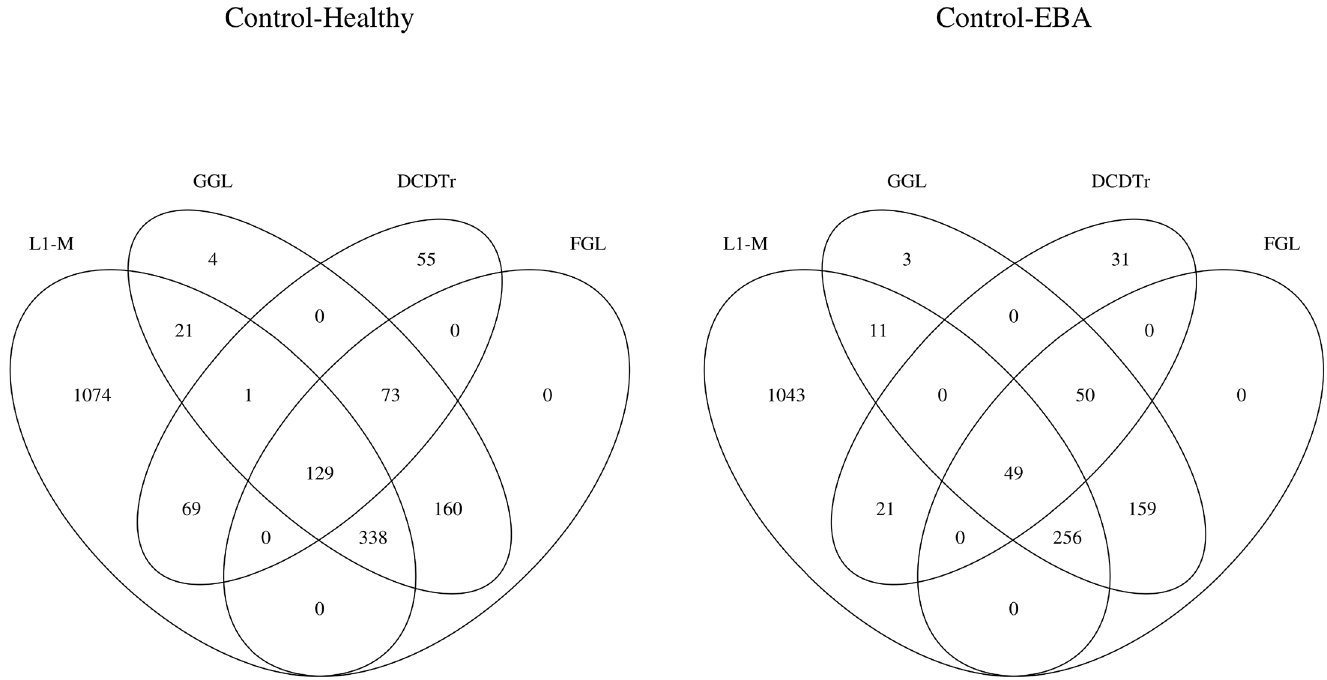
Fig 2. Venn diagrams of shared edges among differential networks from various methods.